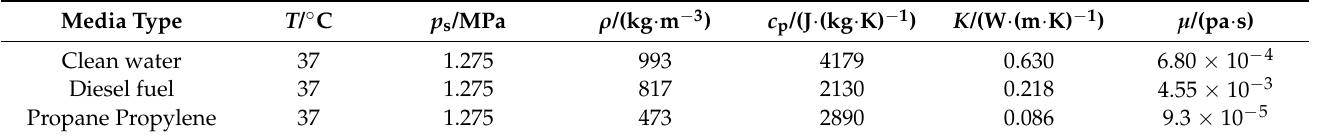
Table 1. Physical parameters of several commonly used sealing mediums.